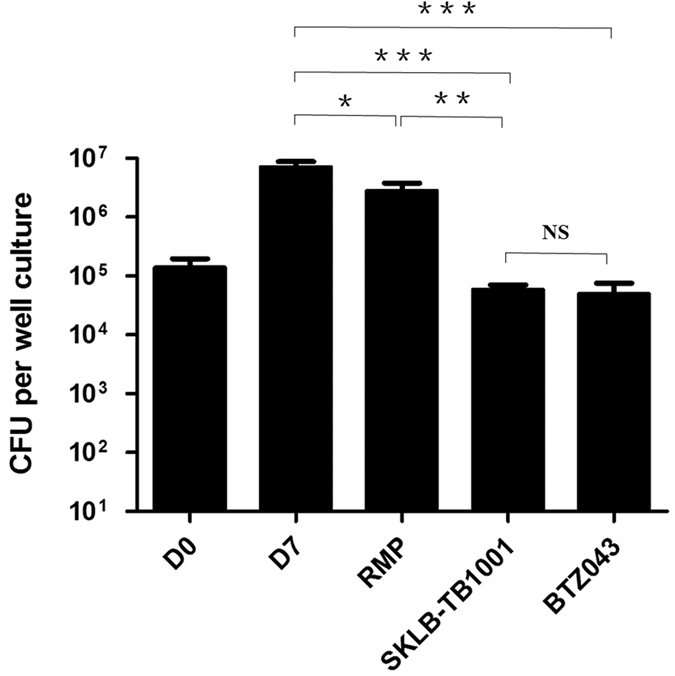
Antimicrobial activity of SKLB-TB1001 against M. tuberculosis Erdman in J774A.1 cells.Triplicate cultures were treated with antitubercular agents at 0.02 μg/mL. Values represented mean ± SD. D0 and D7 represent the CFU counts of untreated control at the beginning and end of incubation, respectively. P values for comparison of two groups were determined by 2-tailed Student’s t test (*P < 0.05; **P < 0.01; ***P < 0.001 vs D7 group; NS means having no statistically significant).